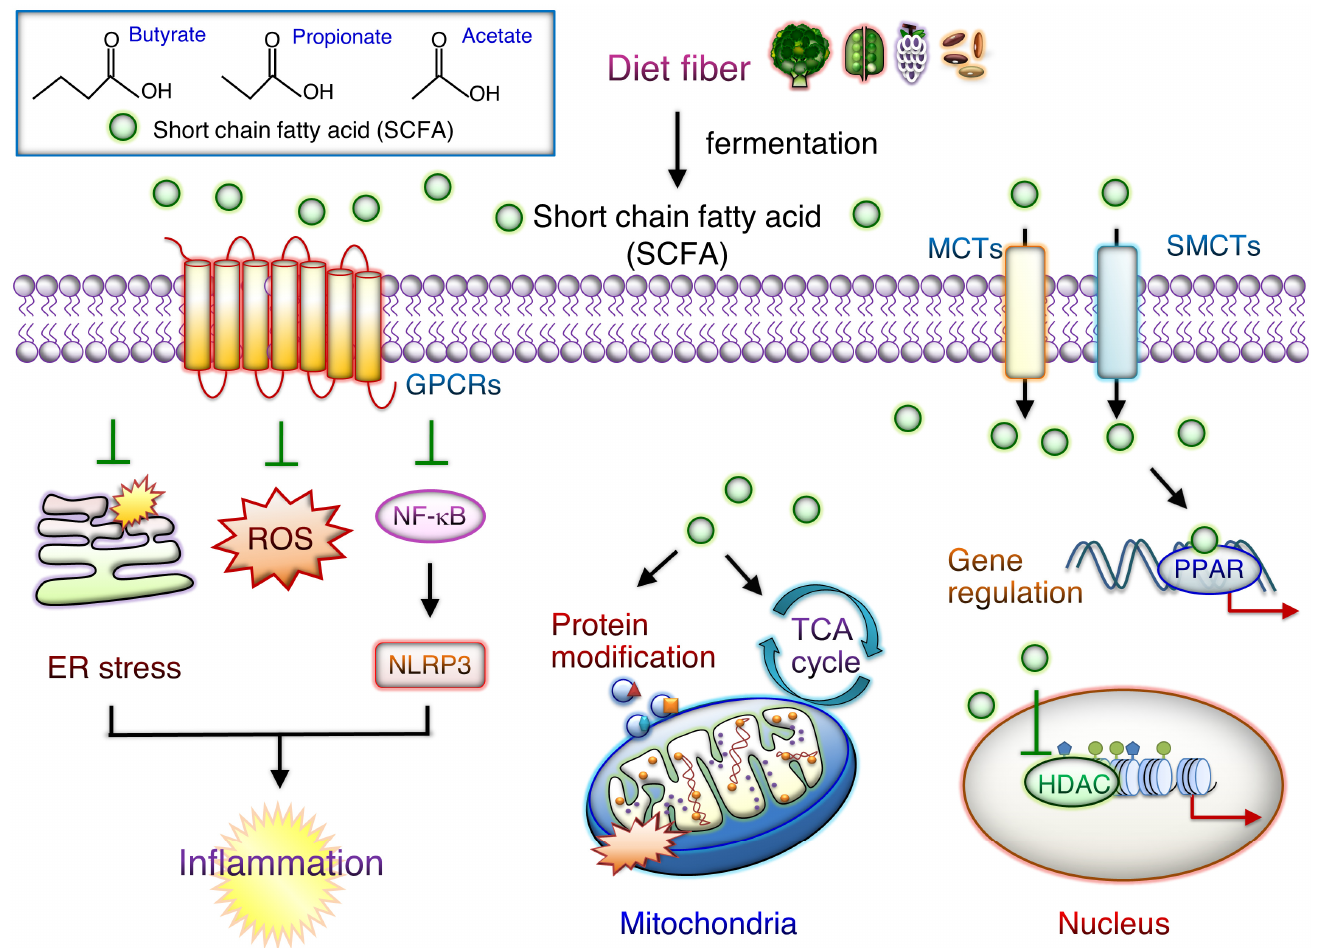
Figure 2. Potential function of SCFAs-mediated cellular downstream signaling. Short-chain fatty acids (SCFAs) bind to G-protein-coupled receptors (GPRCs) on cell membranes and activate down- stream signaling. SCFAs also can enter the cytoplasm either through passive diffusion or membrane transporters, including monocarboxylate transporter 1 (MCT1) and sodium-coupled MCT 1 (SMCT1). GPCRs (e.g., GPR40, GPR41, GPR42, GPR43, GPR91, GPR109A, GPR120, OLFR78, and OLFR78)